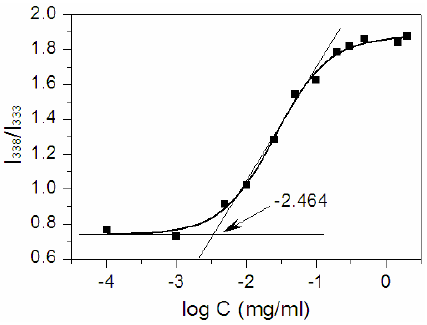
Figure 3. Polt of the intensity ratio I 338 / I 333 (from pyrene excitation spectra of Dex-TOS) as a function of log C.